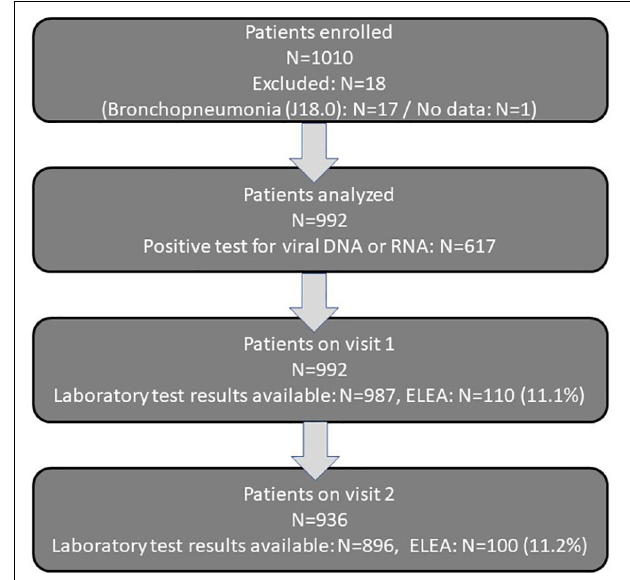
FIGURE 1 | Patient flow in the uncontrolled observational